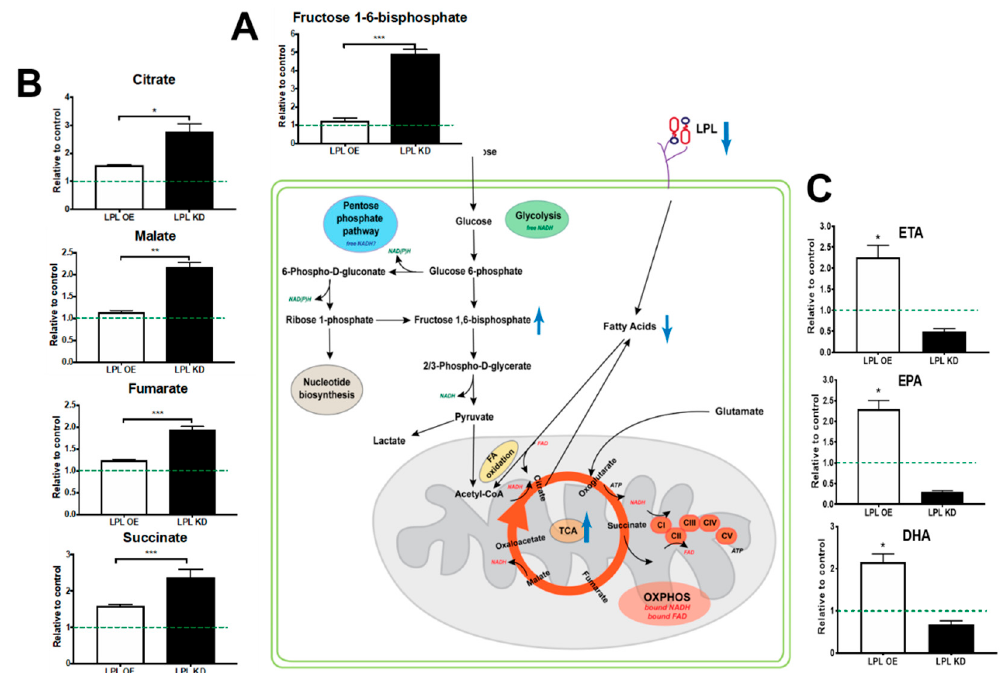
Figure 5. Altered substrate utilization in hypothalamic neurons deficient in or over-expressing LPL. ( A ) LPL KD N41 neurons show increased abundance of fructose 1,6-bisphosphate. ( B ) LPL KD N41 neurons show increased TCA intermediates. ( C ) LPL OE N41 neurons had increased abundance of LC-PUFAs. * = p < 0.05 vs. WT, ** = p < 0.01 vs. WT, *** = p < 0.001 vs. WT .